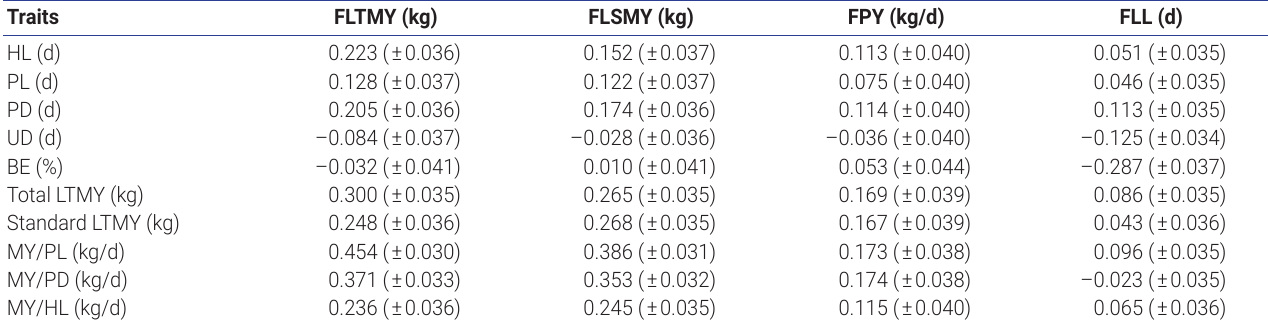
Table 9. Phenotypic correlation between first lactation production and lifetime traits in Murrah buffaloes